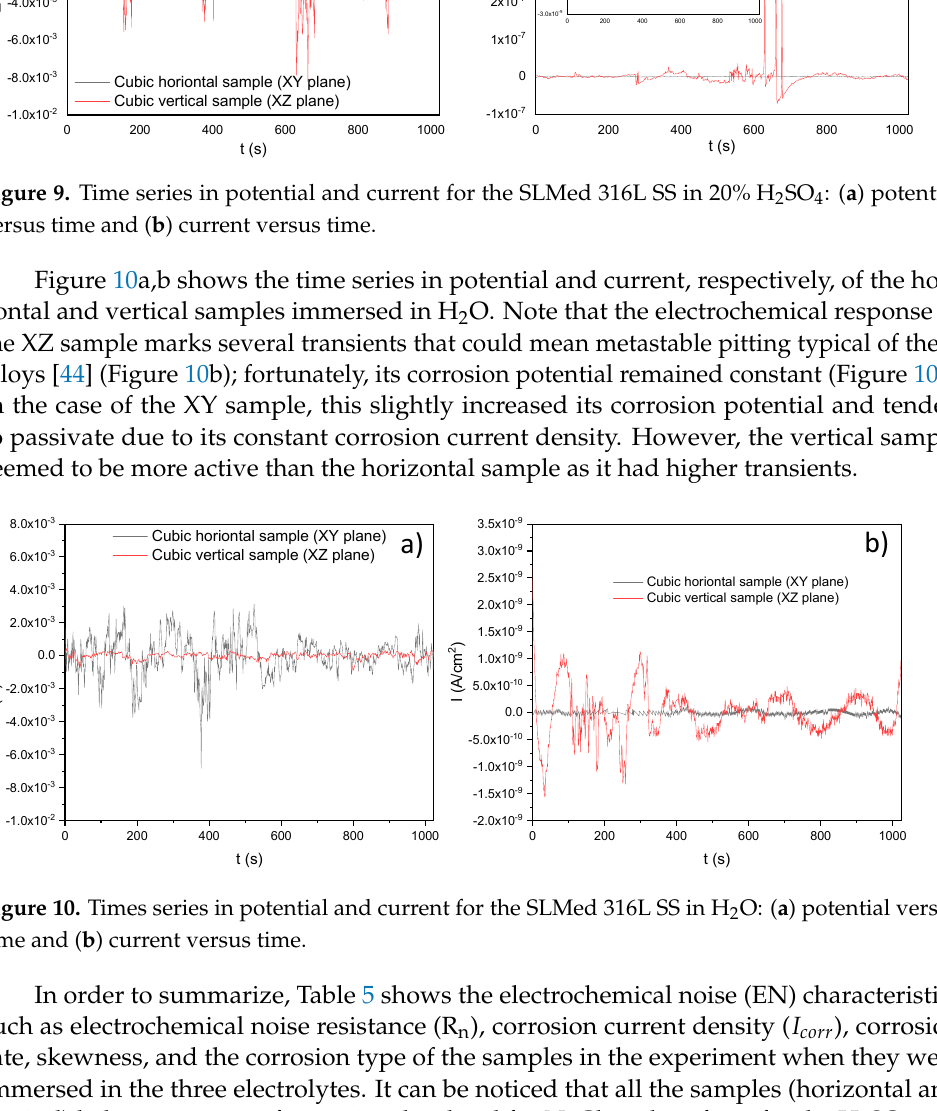
Table 5. Electrochemical noise (EN) characteristics of the SLMed 316L SS tested in the three elec- trolytes ( 3.5 wt. % NaCl , 20% H (cid:2870) SO (cid:2872) , and H (cid:2870) O(cid:4667) Electrolyte